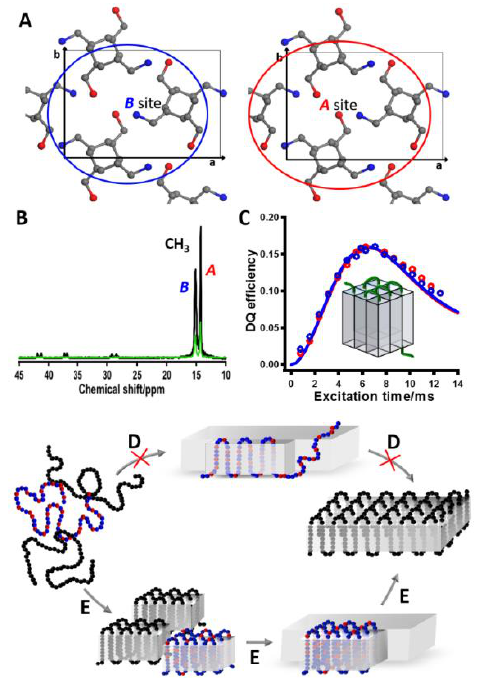
Figure 7. ( A ) Orthorhombic packing structure of i PB1 form III and two magnetically inequivalent CH 3 sites colored by blue ( B ) and red ( A ). ( B ) T 1 ρ H filtered 13 C CPMAS (black) and DQ (green) NMR spectra for 35% 13 C CH 3 enriched i PB1 form III single crystal blends with nonl-abeled chains at a blending ratio of 1:9, crystallized in dilute solution at 50 °C. ( C ) The DQ buildup curves for the 13 C labeled CH 3 signals at A (red) and B (blue). The corresponding calculated curves based on the 3D clusters including twelve stems in four layers at < F > = 65% [57]. Two possible chain-folding mechanisms: ( D ) primary nucleation in solution and ( E ) secondary nucleation on the growth front [57]. (Reprinted with permission from ACS Macro Lett . 2016 , 5 , 355 – 358. Copyright (2016) American Chemical Society).